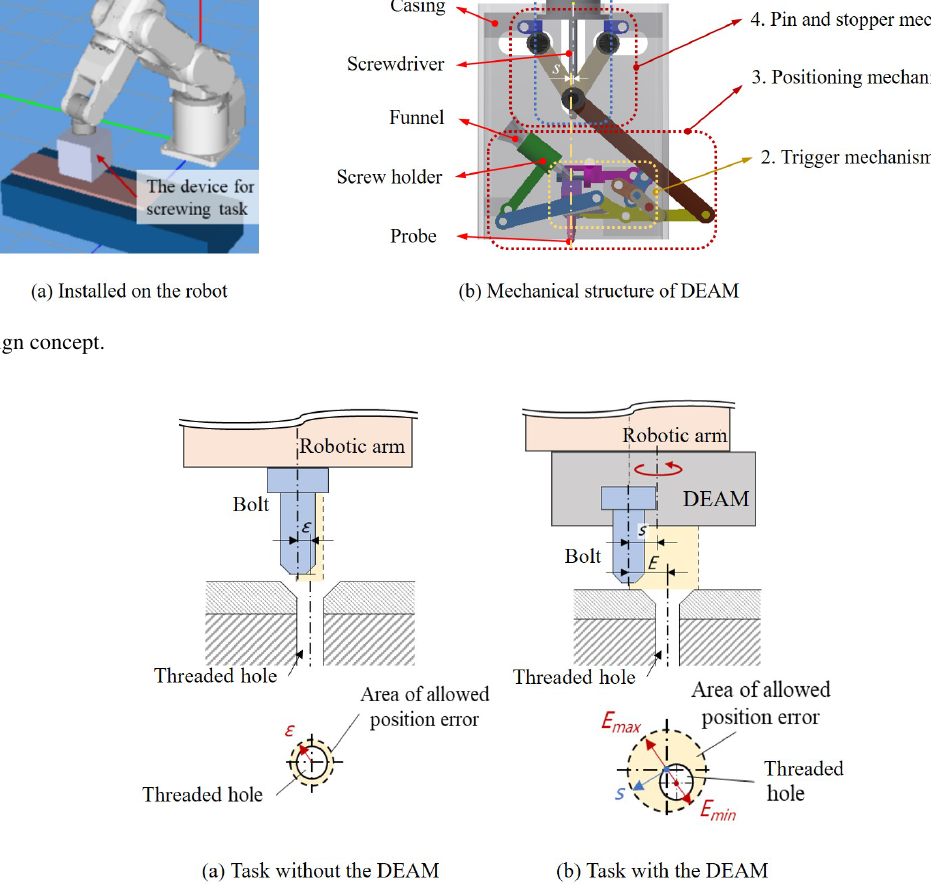
Figure 2. Allowed position error, with and without the